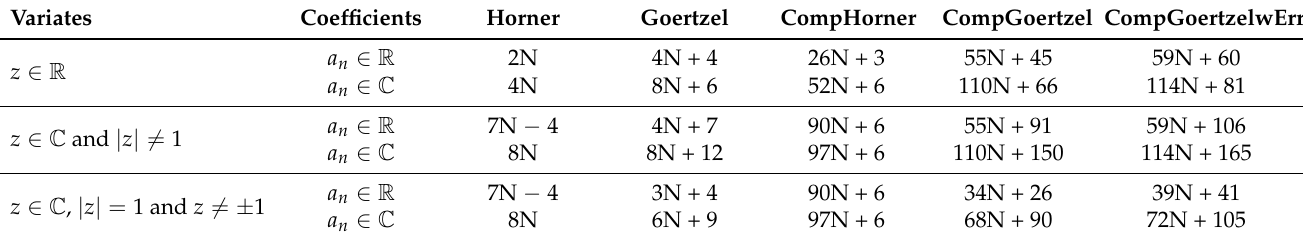
Table 2. Comparison of computational costs of Horner , Goertzel , CompHorner , CompGoertzel and CompGoertzelwErr